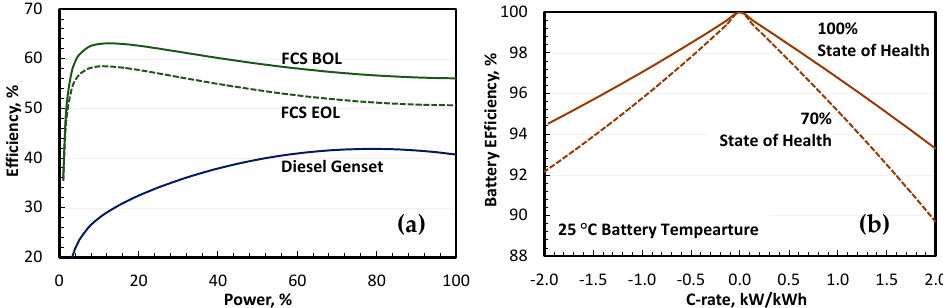
Figure 2. Steady-state FCS and battery performance are presented to illustrate the effect of degra- dation. Actual performance is dynamic and depends on ambient temperature. ( a ) FCS and diesel genset efficiencies at steady state; ( b ) battery charge and discharge efficiencies at steady state.